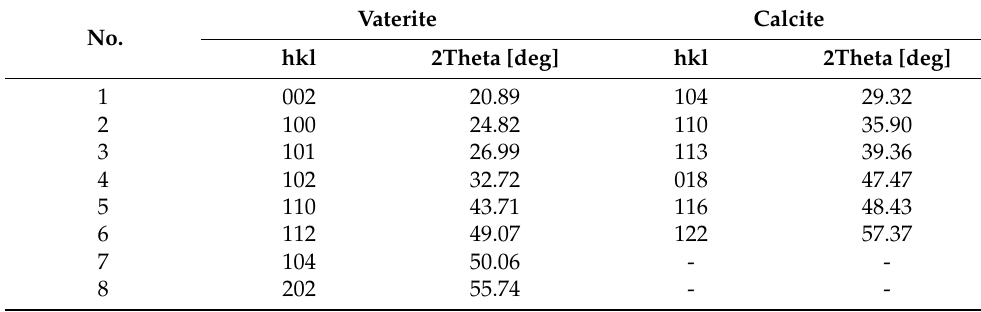
Table 1. hkl plane of vaterite and calcite peaks.